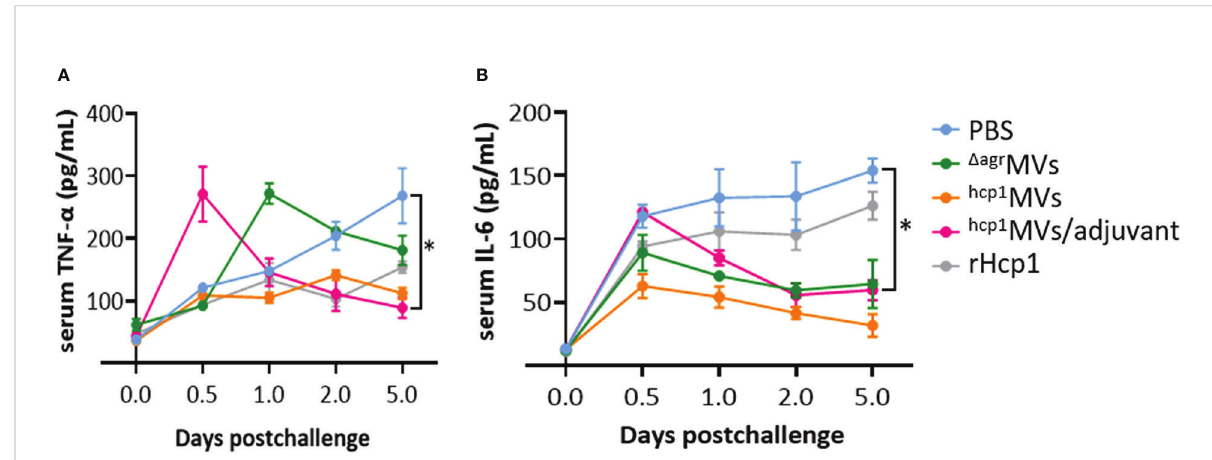
FIGURE 5 The in fl ammatory cytokine levels in sera of vaccinated mice after B. pseudomallei challenge. Mice ( n = 3 per group) were vaccinated with PBS, D agr MVs, hcp1 MVs, hcp1 MVs/adjuvant, or rHcp1 by three inoculations at 10-day intervals. Ten days after the fi nal boost, mice were infected with lethal dose of B. pseudomallei BPC006 (5 × LD50) via intraperitoneal injection. Serum samples were harvested on days 0.5, 1, 2, and 5 postinfection and the levels of in fl ammatory cytokines, including TNF- a (A) and IL-6 (B) , were determined by ELISA. Data are presented as mean ± SD. Statistical signi fi cance was calculated by two-way ANOVA, * P <